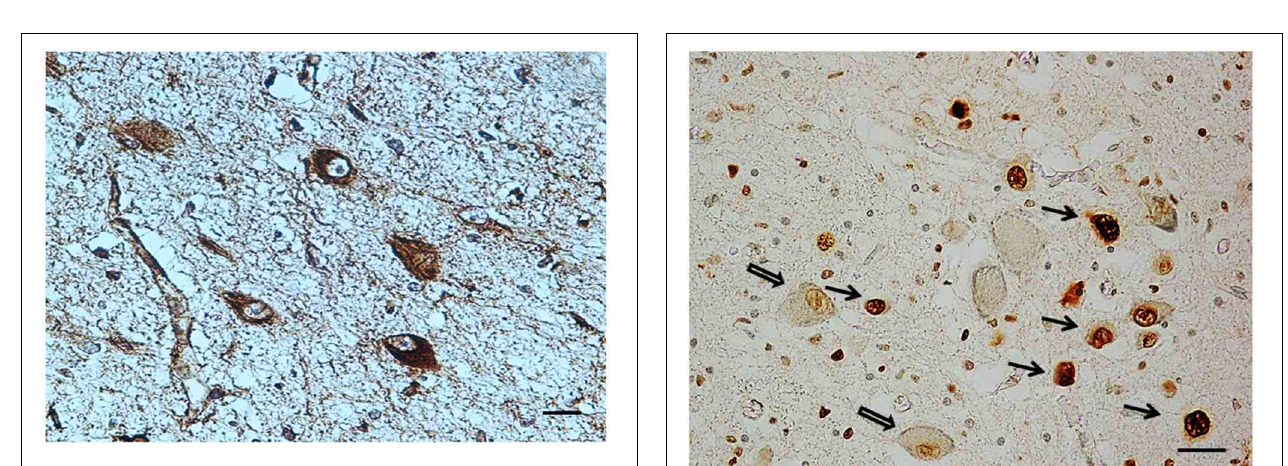
FIGURE 3 | The Kölliker-Fuse nucleus in a histological section of rostral pons of a control newborn (3 month-old). The boxed area in (A) is represented at higher magnification in (B) . At this magnification it’s possible to recognize the large Kölliker-Fuse neurons with distinct nucleus and evident nucleolus (arrows indicate some of these neurons), intermixed to smaller